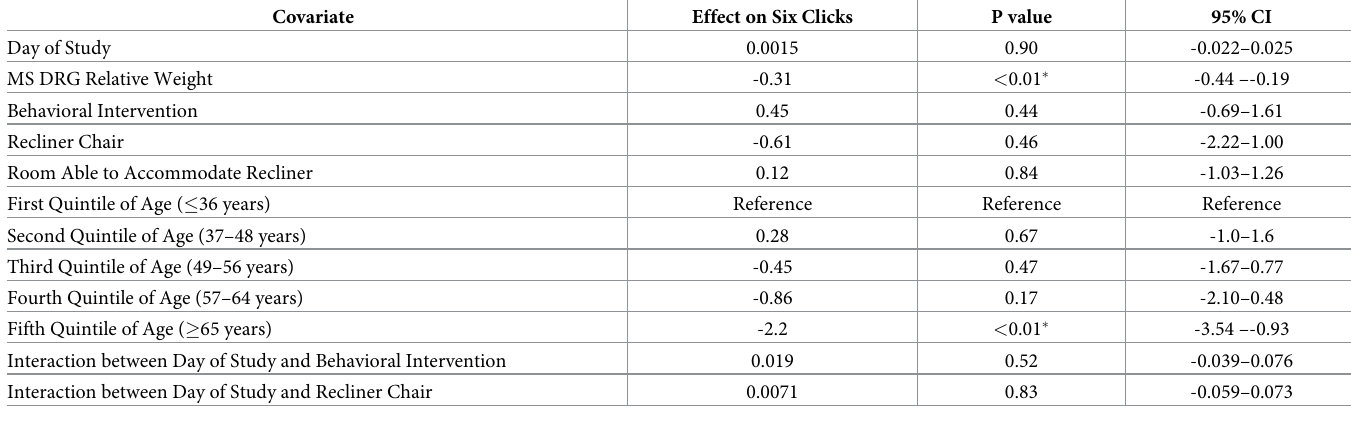
Table 3. Multivariate analysis of “6-clicks” functional status score (N = 778).